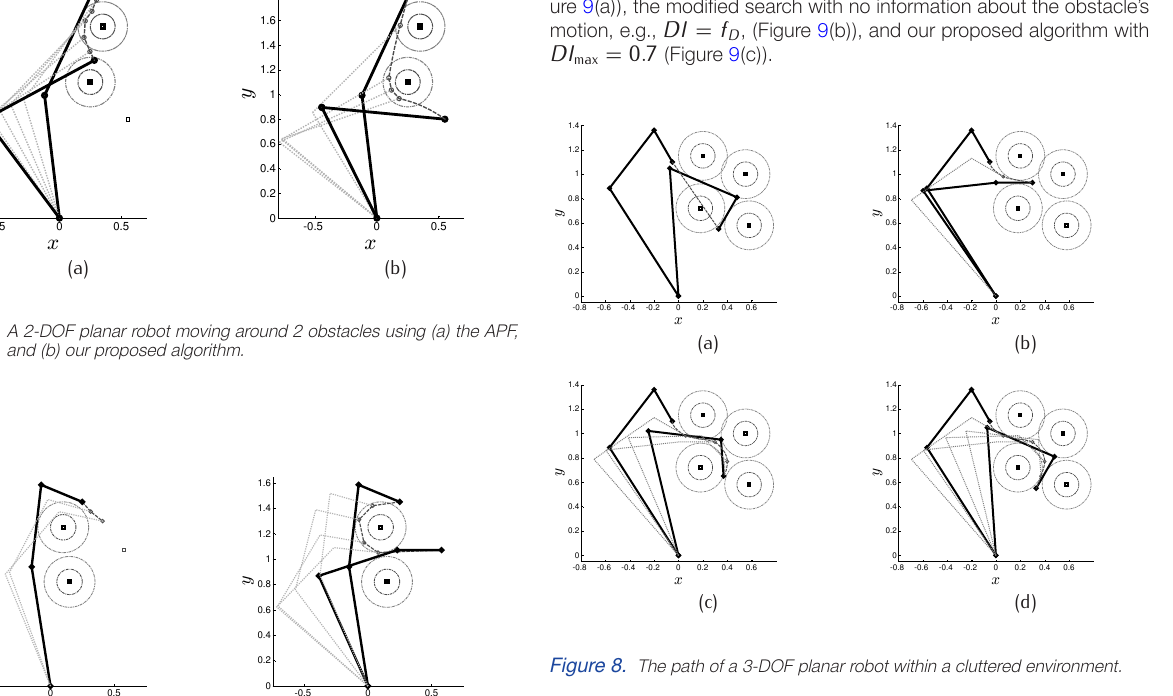
Figure 8. The path of a 3-DOF planar robot within a cluttered